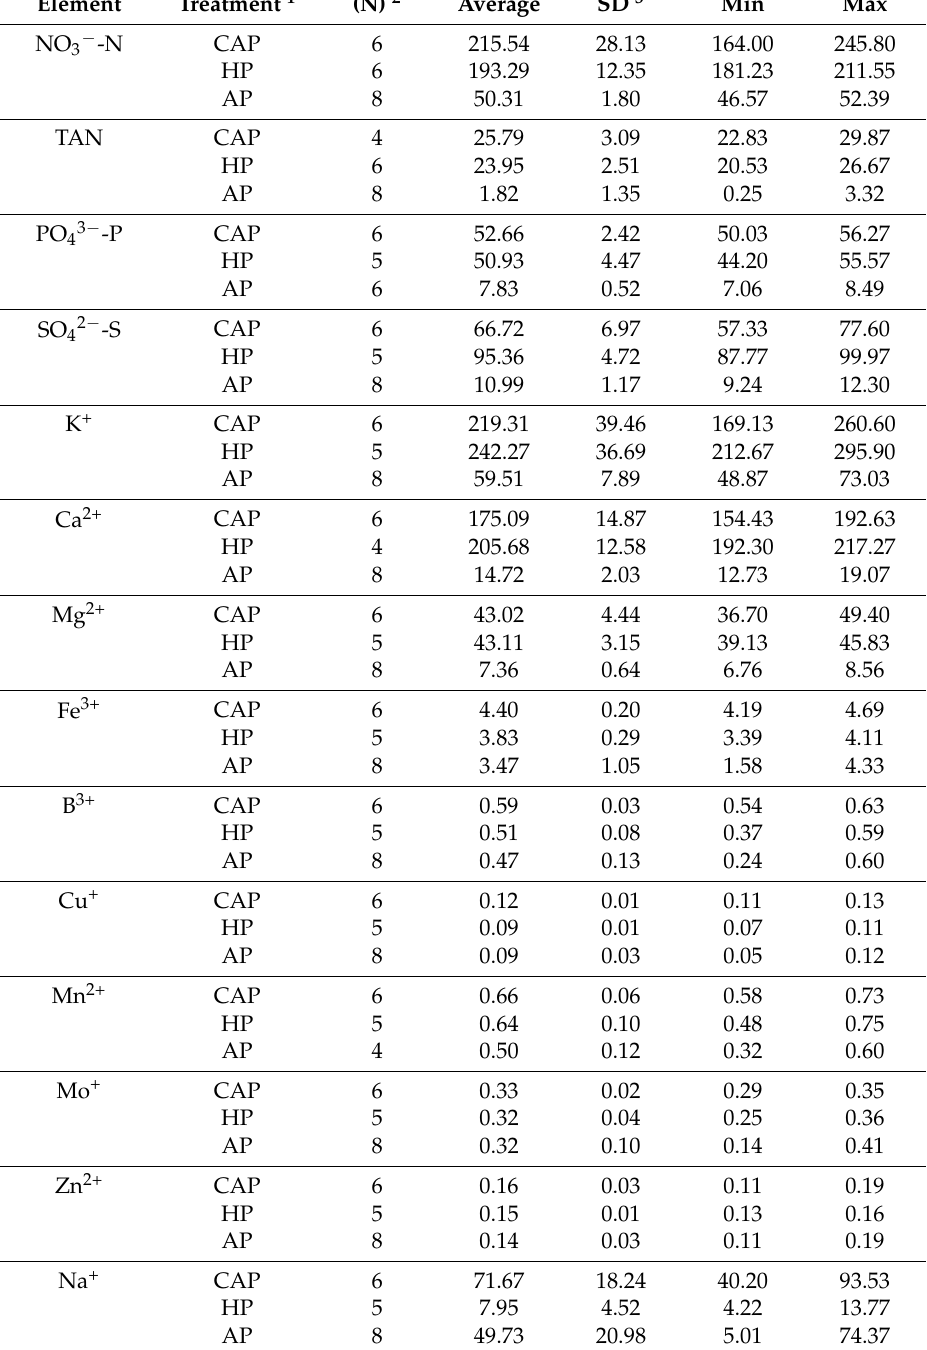
Table 4. Average of the LS mean of macro- and micronutrients concentration in CAP, HP, and AP treatments for trial 2